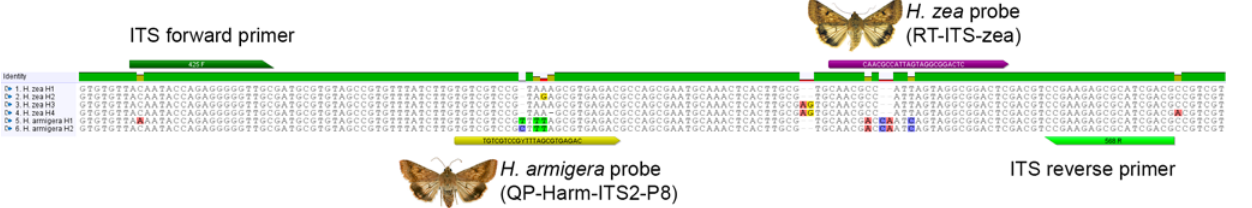
Fig 1. Alignment of ITS2 for H . armigera and H . zea showing sequence variation along with primer and probe locations.